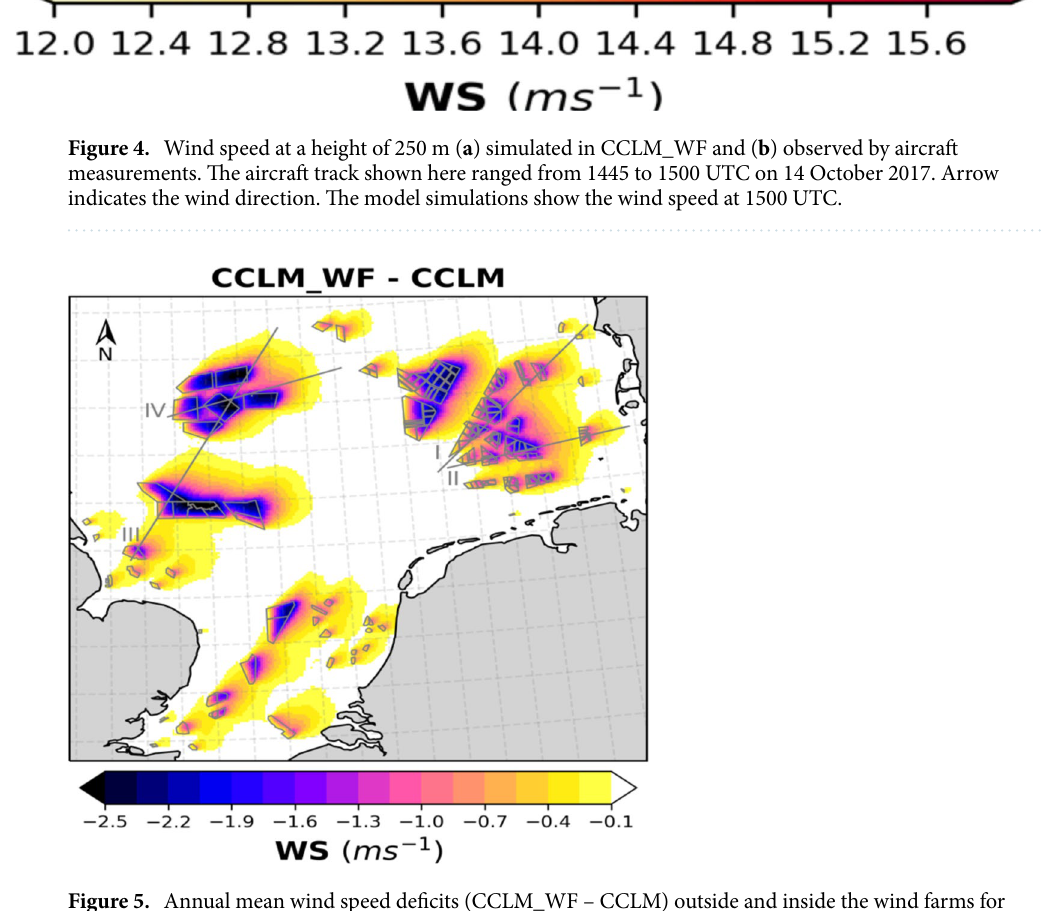
Figure 5. Annual mean wind speed deficits (CCLM_WF – CCLM) outside and inside the wind farms for the prevailing wind directions of 200°–280° at hub height (90 m) in the period 2008–2017. Numbered gray lines indicate the transects used for calculations of Fig. 8 and Fig. SI 6 and SI 7. This figure was created with Matplotlib (Hunter, J. D., Matplotlib: a 2D graphics environment. Computing in Science and Engineering 9 , 2007) and Cartopy (Met office, Cartopy: a cartographic python library with a matplotlib interface. Exeter, Devon, https:// scito ols. org. uk/ carto py,